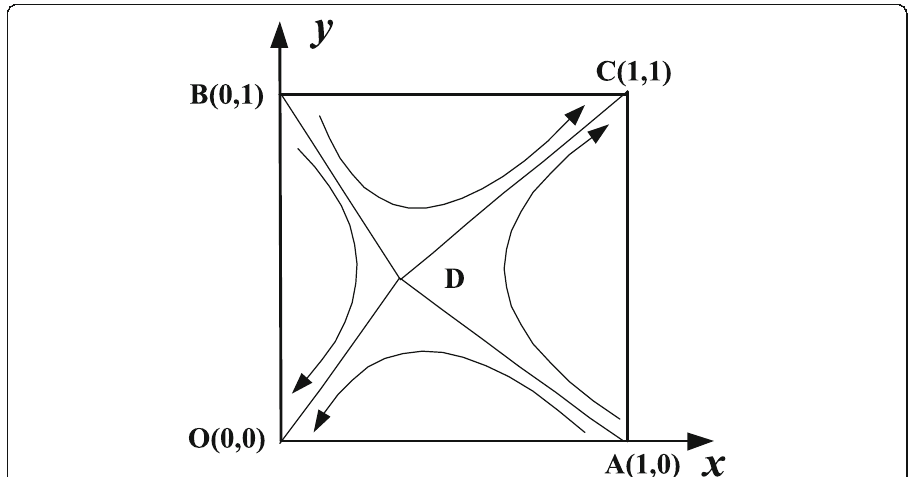
Fig. 7 The evolution phase diagram about core enterprises and cooperative enterprises. Source: Authors ’